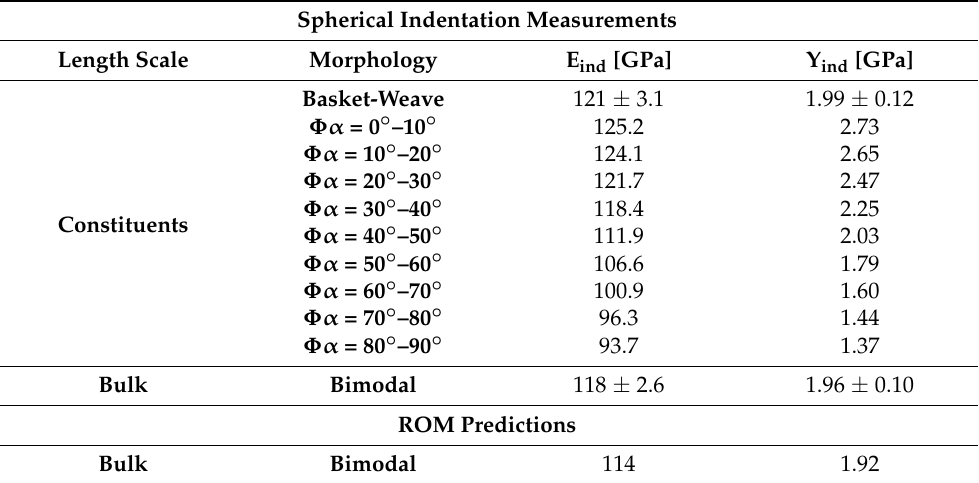
Figure 5. Results from the spherical indentations performed on the primary a grains, plotted as a function of the declination angle ( Φ ). Experimental results are shown as blue circles, and the values estimated from regression analysis at the mid points of each bin are depicted as yellow diamonds. Table 2. Measured indentation moduli and indentation yield strengths for the different microscale constituents as well as the bulk responses of the material studied in this work. The last row provides the corresponding predictions from the application of the ROM